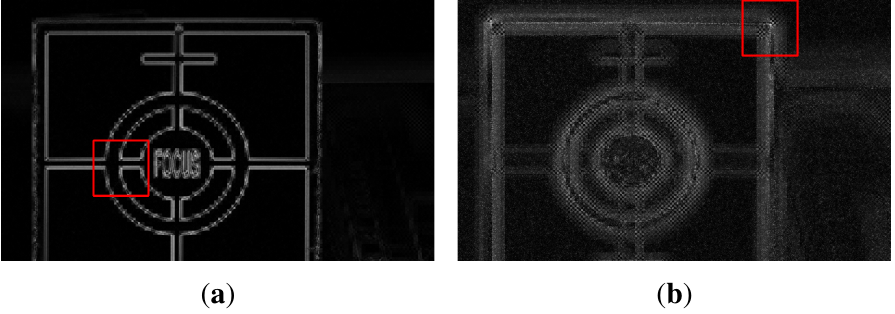
Figure 13. Results of feature extraction in the cropped region of Figure 12: ( a ) the feature of the in-focus image shown in Figure 12b,d and ( b ) that of the front-focus image shown in Figure 12a.